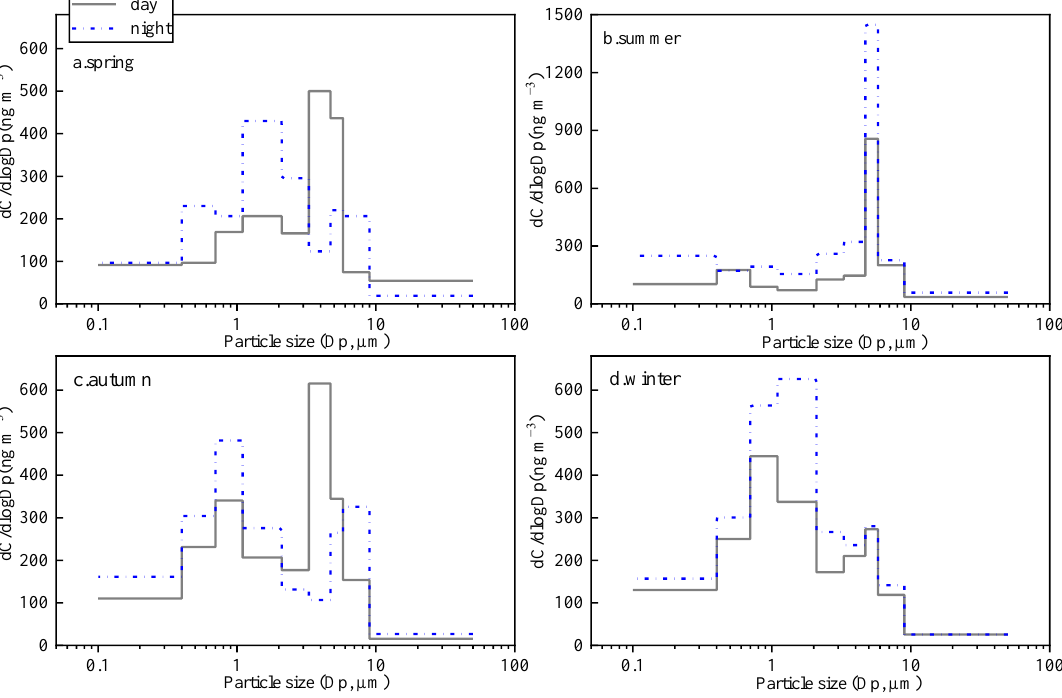
Figure 4. Seasonal particle size distributions of n-alkanes (( a ). spring day and night; ( b ). summer day and night; ( c ). autumn day and night; ( d ). winter day and night).